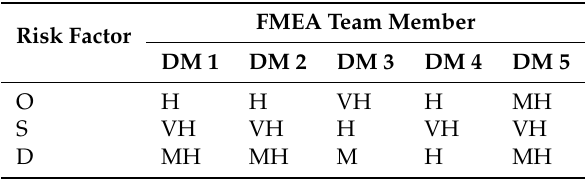
Table 6. The evaluations to the weights of risk factors from the FMEA team.